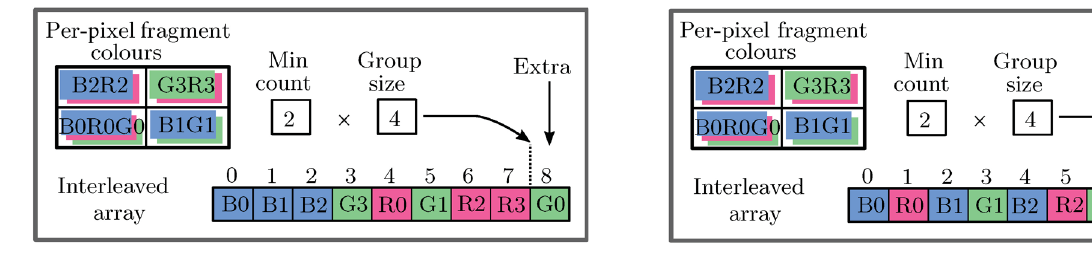
Fig. 6 Per-pixel blue/red/green, blue/green, blue/red, and green/red fragment colours as a blocked interleaved array with block size 2. rasterized, then threads are instead executed in pixel rasterization order. nVidia GPUs typically rasterize pixels in a tile-based fashion, where a 2 × 8 tile is rasterized in a zig-zag pattern. Figure 7 shows the rasterization order for a 4 × 8 block of pixels; numbers represent execution order of per-pixel fragment shader threads as determined by atomic counters. Indexing pixels to more closely match the repeating 2 × 8 tiled raster pattern when building the deep image improves merging performance by approximately 1.5 to 2 fold for all approaches.